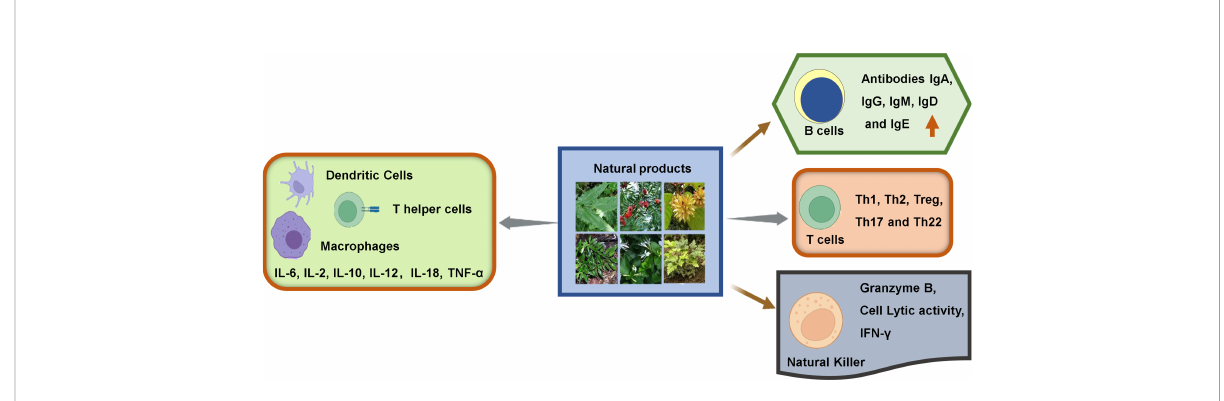
FIGURE 2 Immunomodulatory effects of natural products on immune cells within